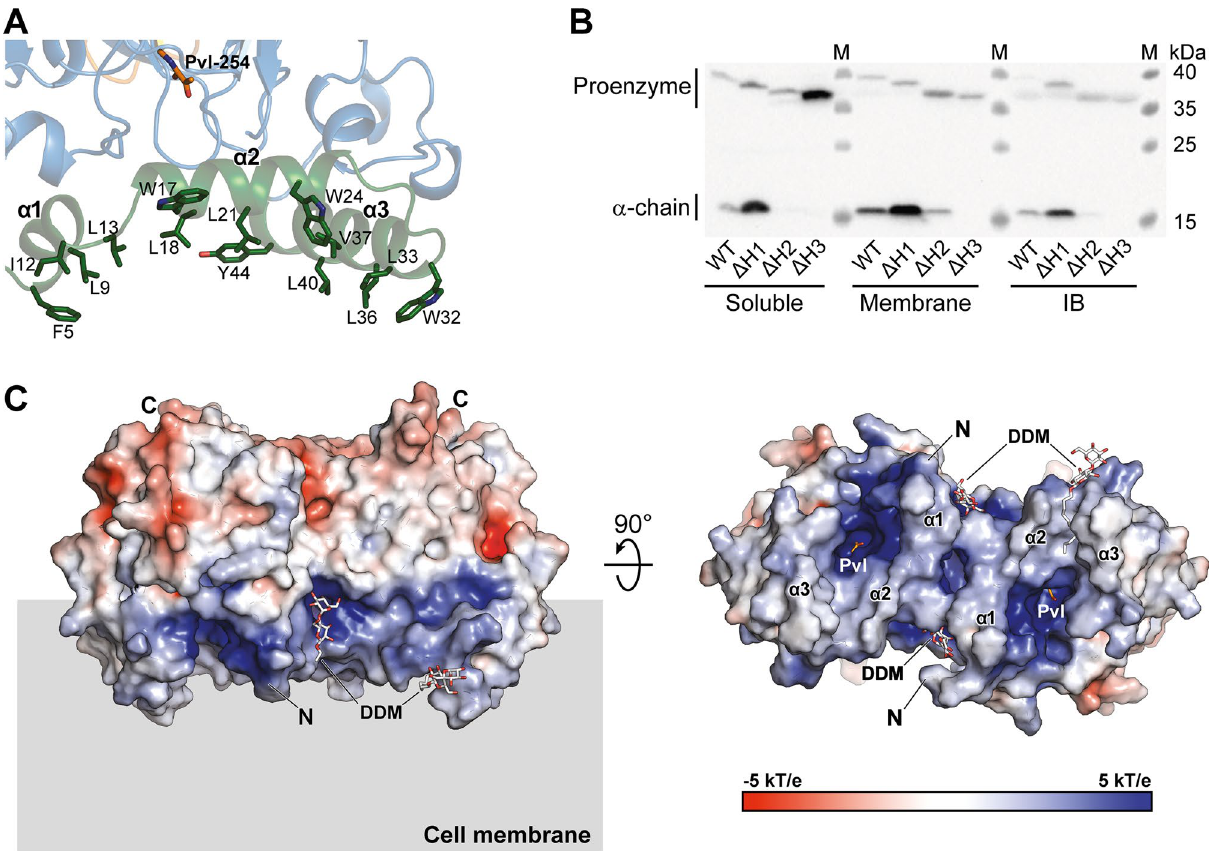
Figure 3. N-terminal three-helices are crucial for membrane binding and auto-cleavage. ( A ) Amphipathic nature of N-terminal helices are displayed in light green and the hydrophobic residues are labeled and highlighted in dark green. ( B ) Membrane association assay of PSD full-length (WT, 1–322), α1-helix (ΔH1, 13–322), α1–2 (ΔH2, 30–322), and α1–3 truncated (ΔH3, 46–322). The proteins were heterologously expressed in E. coli . The cells were lysed by sonication in non-detergent solution (PBS, phosphate-buffered saline), and separated into soluble, membrane, and inclusion body (IB) fractions by sequential rounds of centrifuge and ultracentrifuge. Each fractions were analyzed by 12% SDS-PAGE and western blotting using anti-histag antibody. Lane M ladder marker. ( C ) Distribution of electrostatic potential on αβ-heterotetramer. Left and right, two views are same as in Fig. 2A. The surface with positive charge is displayed in blue, negative in red, and neutral in white. Approximate location of cell membrane is shown as gray box. N-terminal three-helices are designated on the left